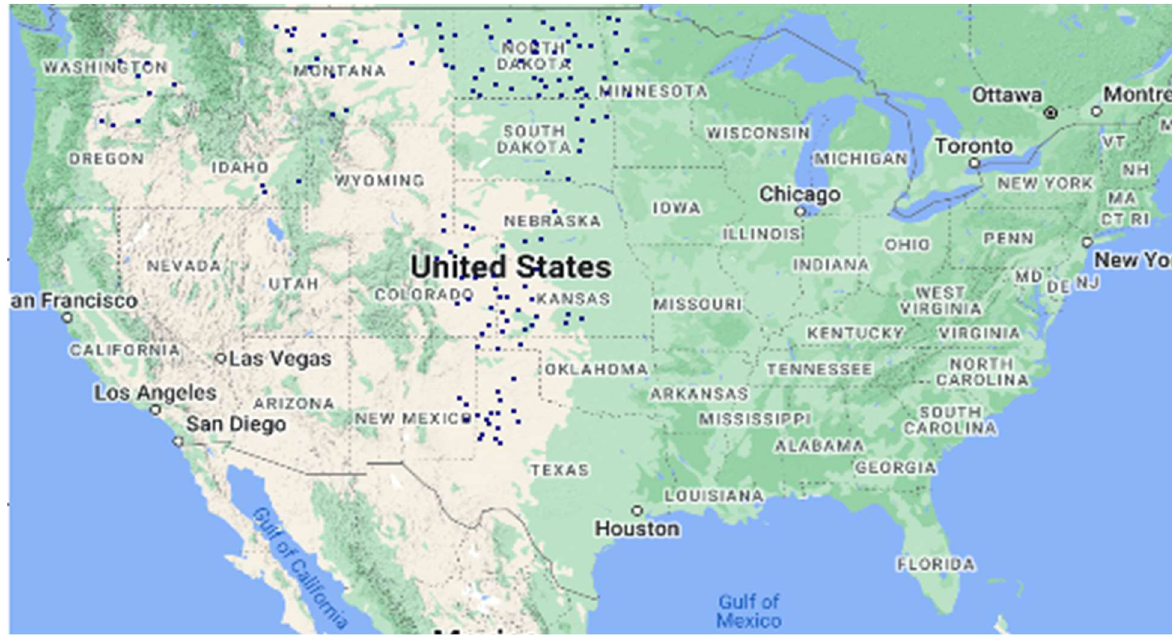
Figure 8. Cluster 6 (146 counties from 15 different